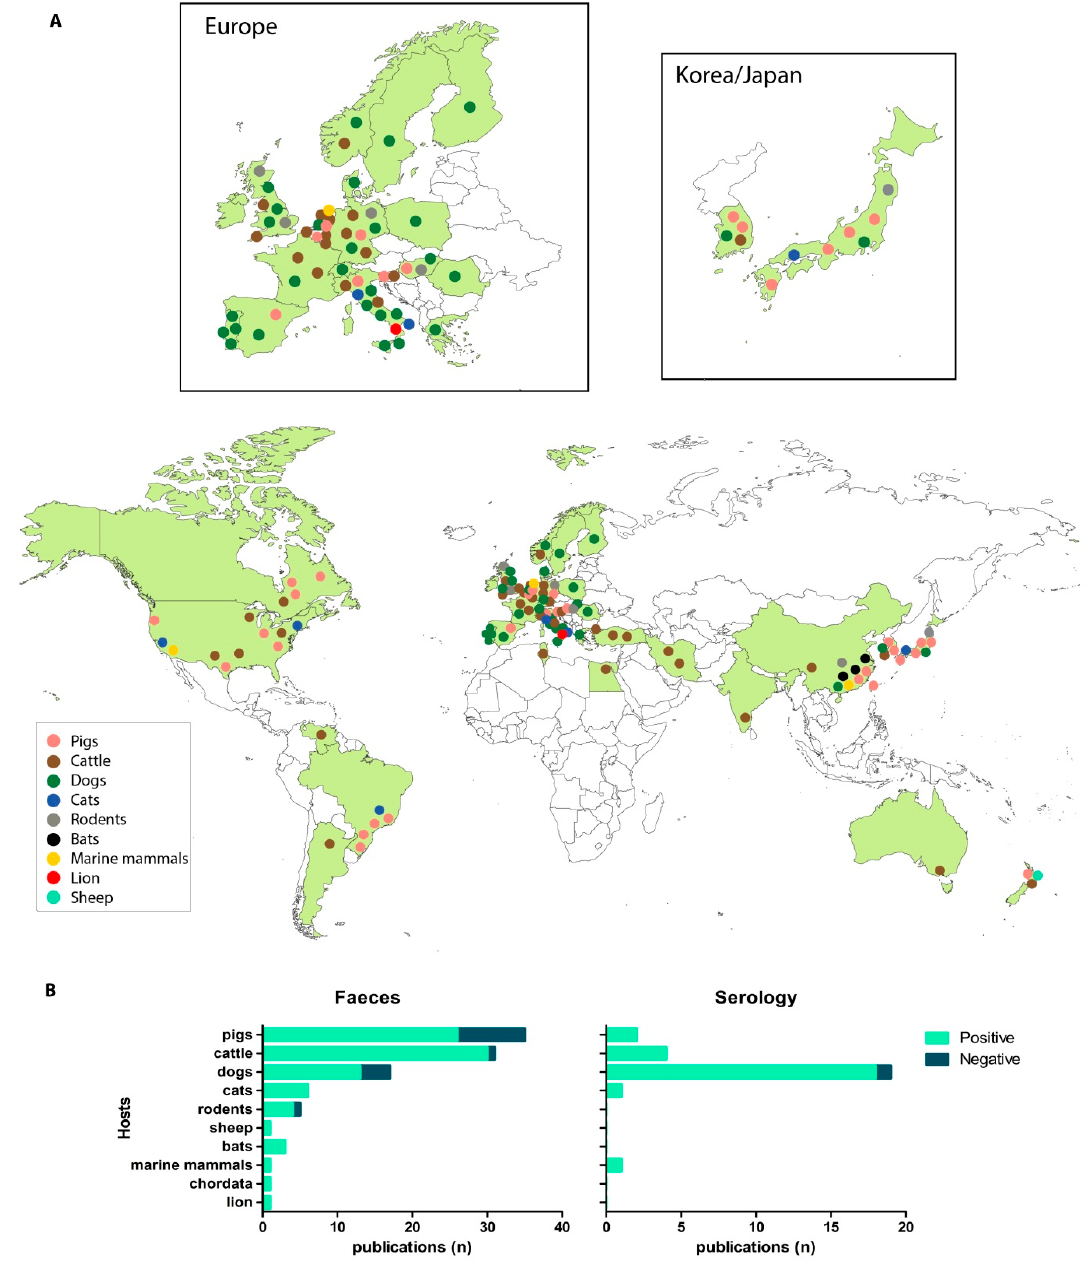
Figure 1. Studies describing the presence of animal norovirus across the world. ( A ) Countries in which animal norovirus have been detected are colored green. Each dot represents a study and location where animals have been found positive by either RT-PCR, real-time RT-PCR, or serology. The color indicates the host. ( B ) Number (n) of publications reporting positive versus negative surveillance results in different hosts for PCR results in feces and serology studies. Note that a paper that studied GVI.2 seropositivity in dogs in 14 European countries is listed as 14 studies in 1B [47]. Details of the studies are listed in Table 1 and Supplementary Table S1.